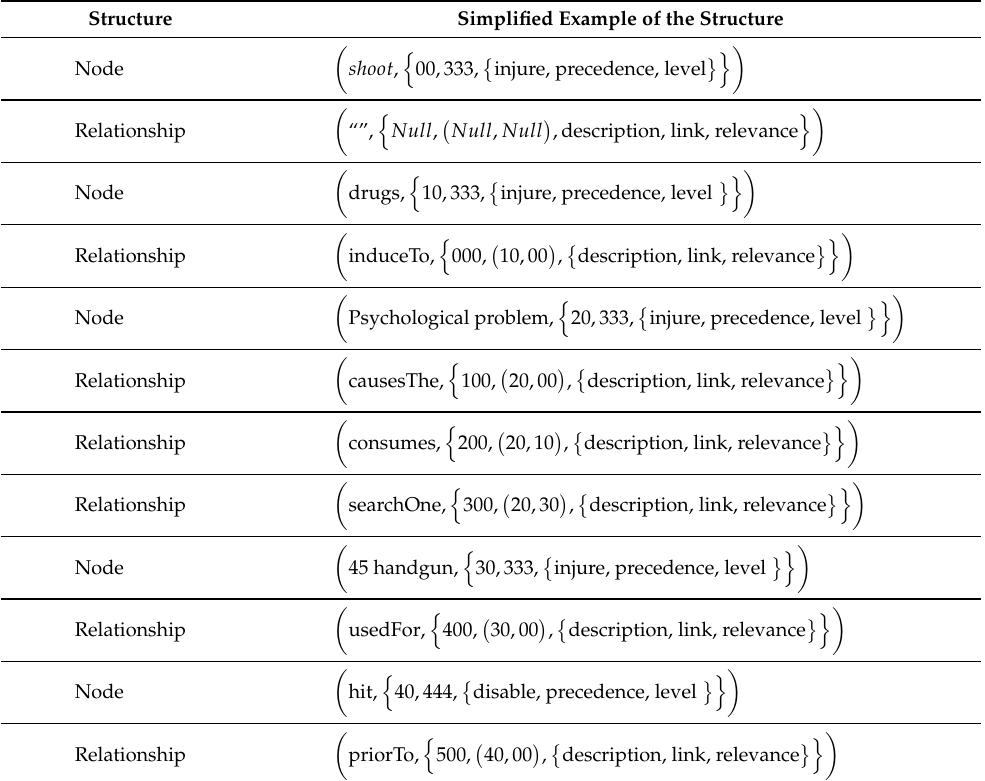
Table A2. Data structures about nodes and relationships in Figure